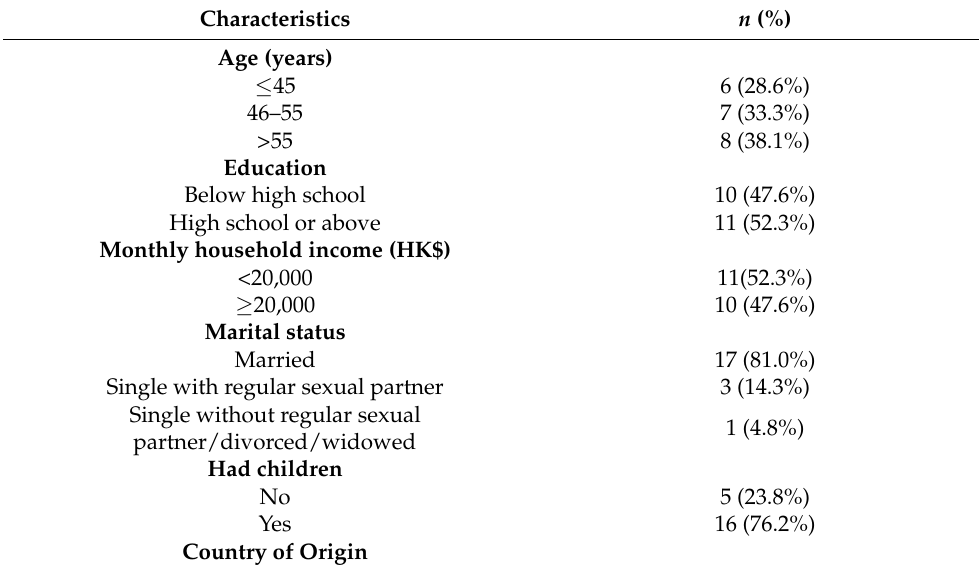
Table 1. Participant characteristics ( n =